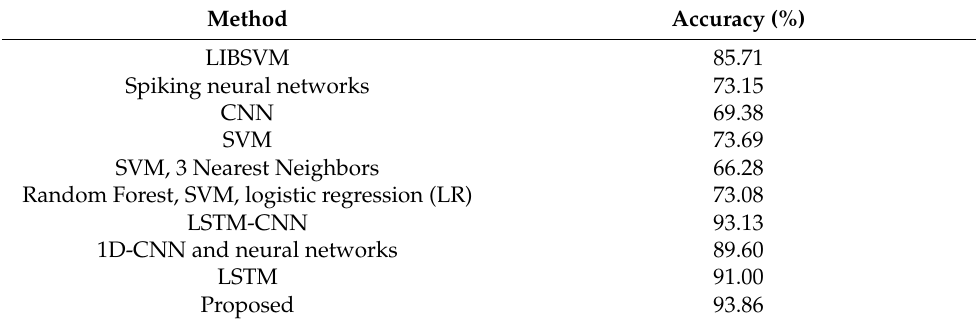
Table 11. Comparison of state-of-the-art methods in terms of accuracy reported in [11].